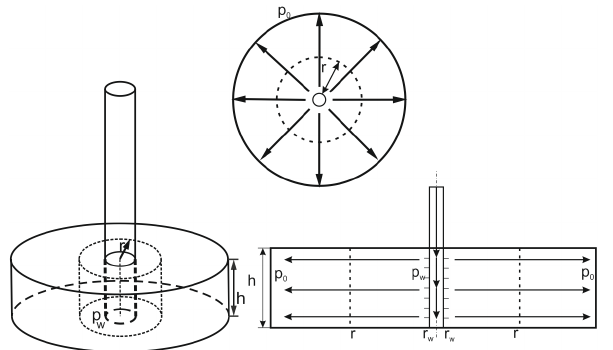
Figure 2. Radial flow in a homogeneous reservoir.